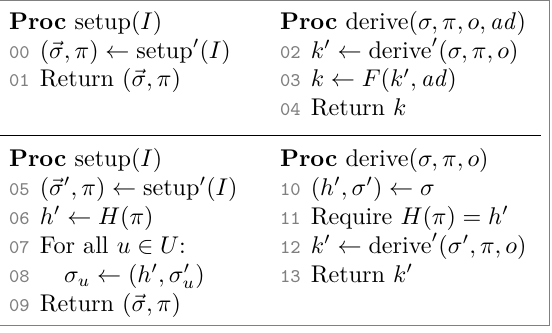
Figure 12: Two constructions of a KAS setup , derive from a KAS setup 0 , derive 0 . We assume building blocks F : K × AD → K and H : { 0 , 1 } ∗ → { 0 , 1 } 256 . If the condition in line 11 is not fulfilled, the derive algorithm fails.